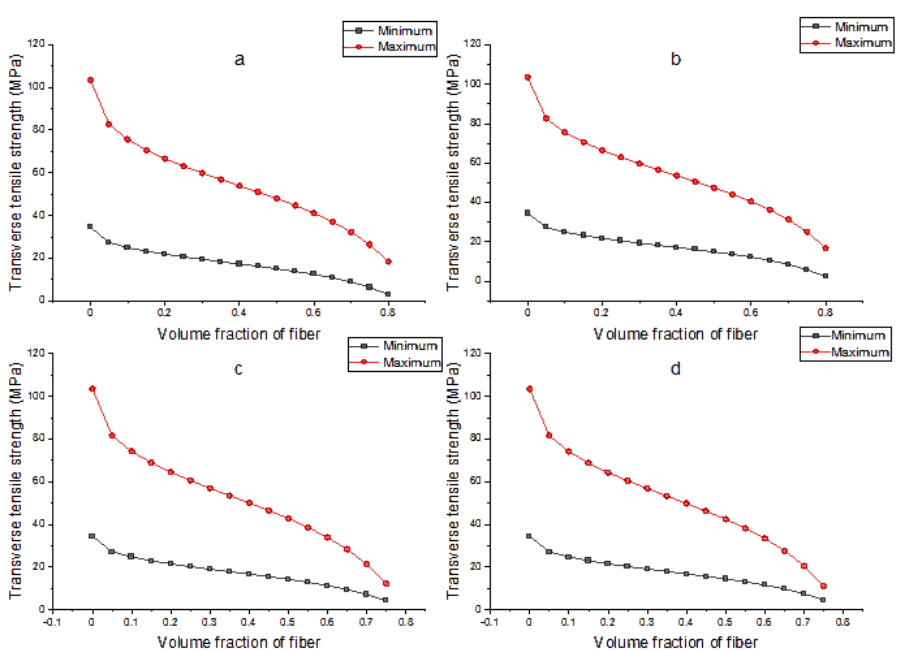
Figure A7. Depicts the variation in transverse tensile strength of ( a ) E-glass, ( b ) S-glass, ( c ) T300 carbon fiber and ( d ) AS carbon with volume of fiber. It can be seen that the value of transverse tensile strength is maximum at 0% fiber ratio but the strength starts to decline and reaches the minimum at 100% fiber ratio.